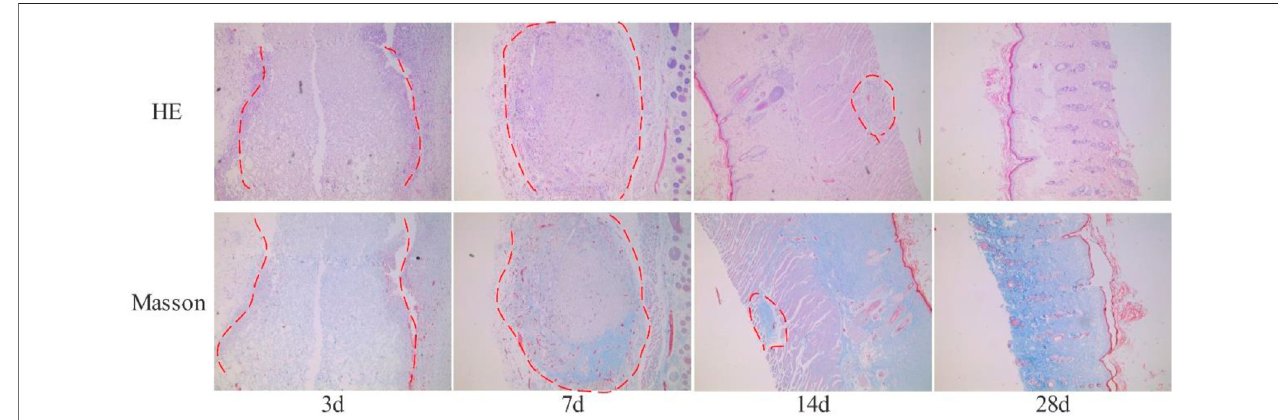
FIGURE4| TheresultsofHEandMassonstaining(×40)areobtainedbysubcutaneouslyembedded fi shcollagensponge(Thereddottedlineshowstheimplanted fi sh collagen sponge).